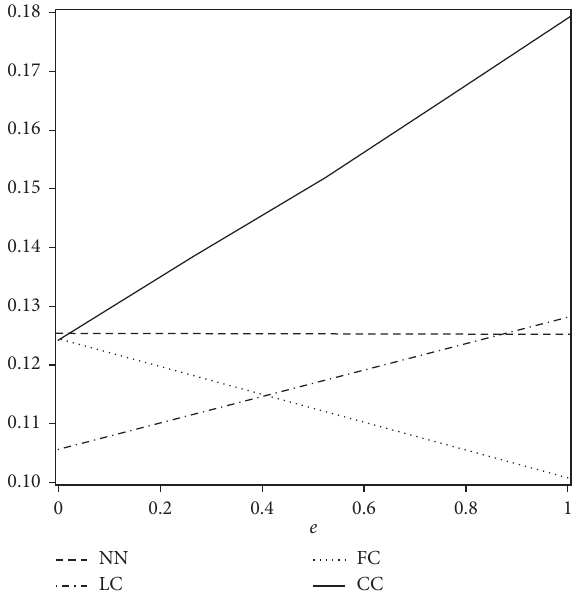
Figure 1: Comparison of the profits of University 1.